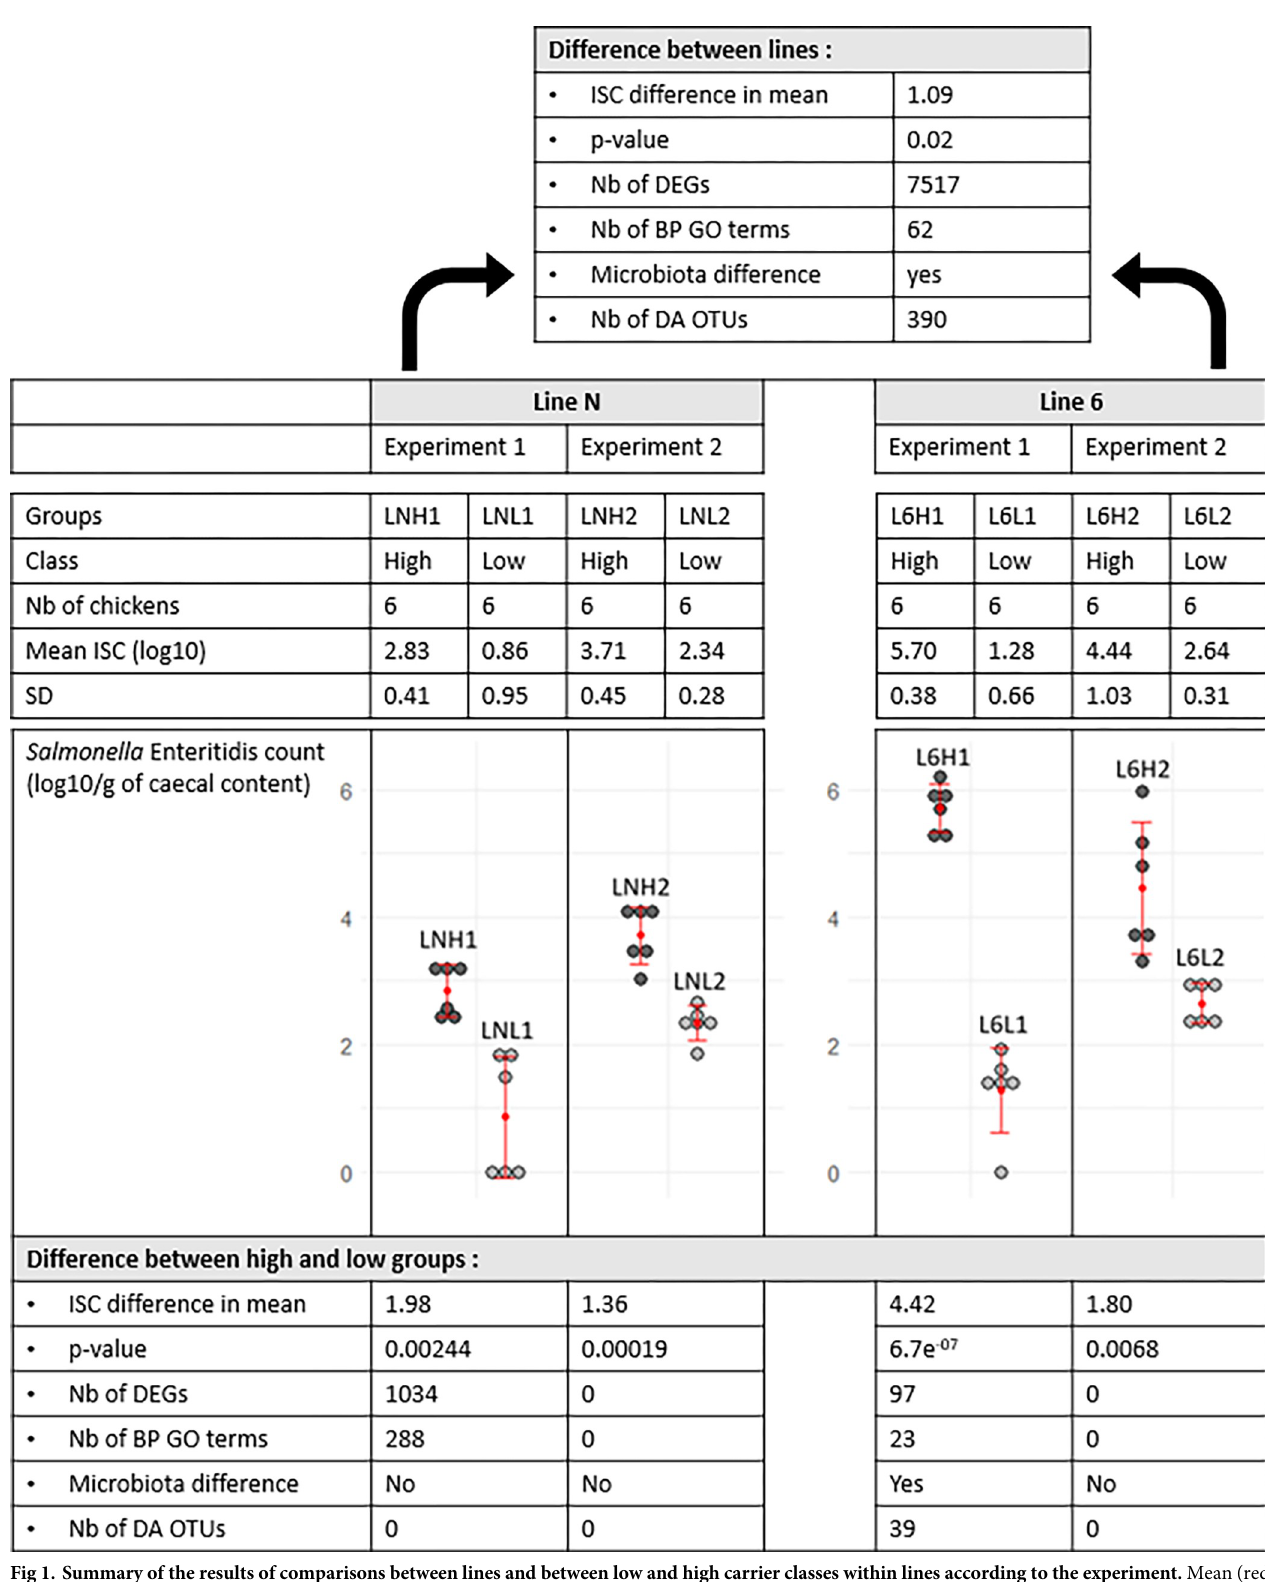
PLOS ONE | https://doi.org/10.1371/journal.pone.0270012 August 17,